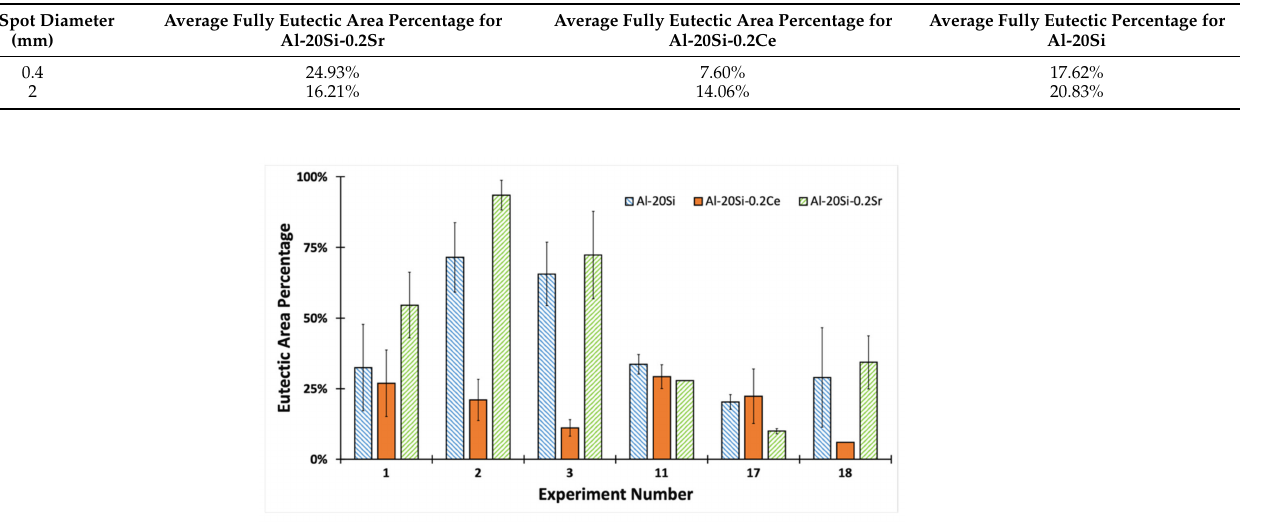
Table 1. Summary of eutectic formation for the initial set of LSR experiments. The Al-20Si-0.2Ce samples had noticeably lower eutectic area percentages compared to Al-20Si-0.2Sr and Al-20Si.